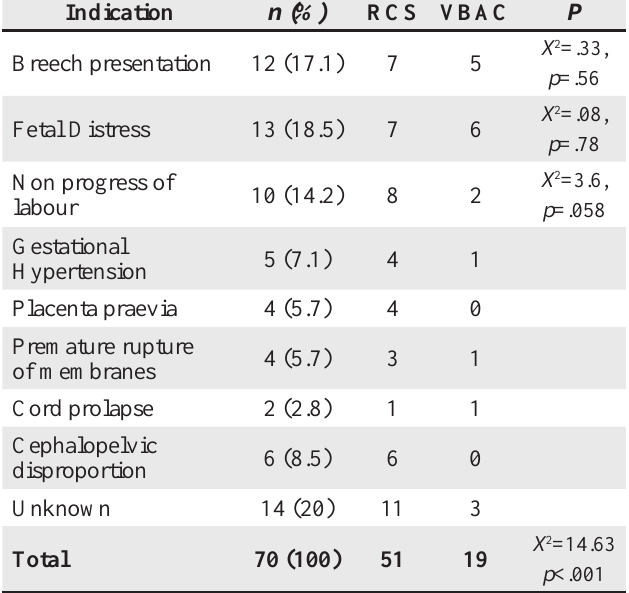
Table 3 . Indication of previous caesarean section and mode of delivery in this pregnancy